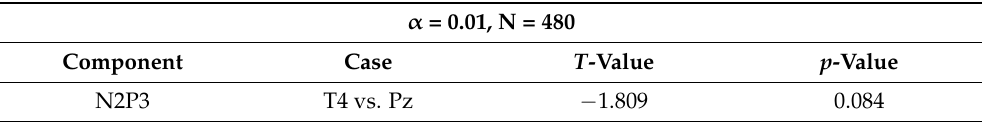
Table 6. Paired samples t-test results of average accuracies for every trial between the best and worst electrodes.